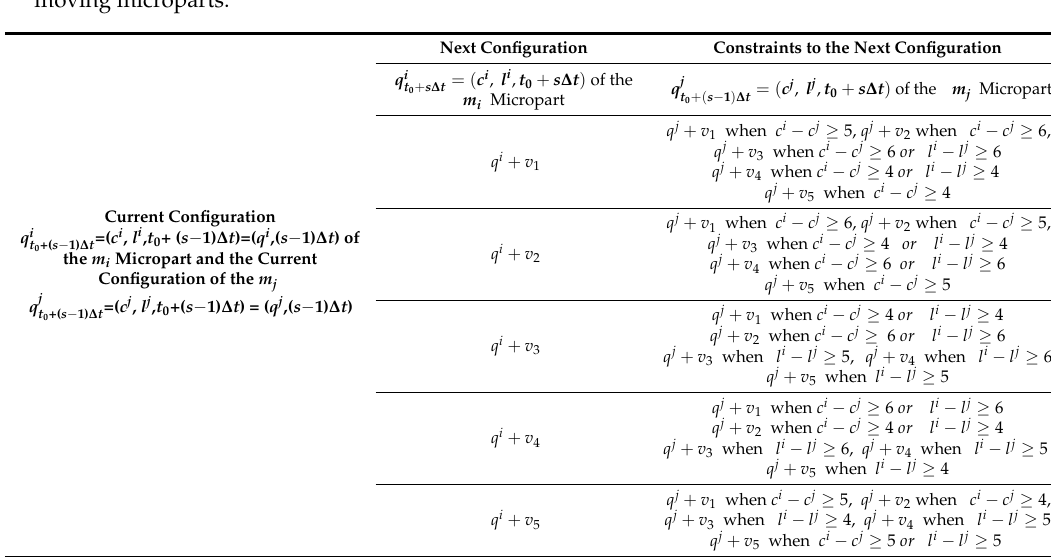
other. Table 3. Possible scenarios for the collision avoidance between the two simultaneously